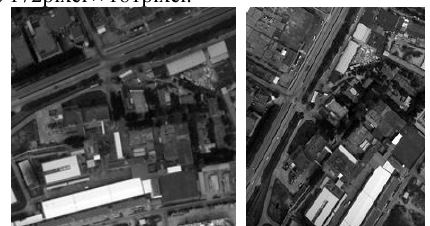
Figure 2(c) parts of low-altitude stereo-images with affine distortion because of the change of view point. The image size of left image is 153pixel  180pixel, and the image size of right image is 172pixel  181pixel.